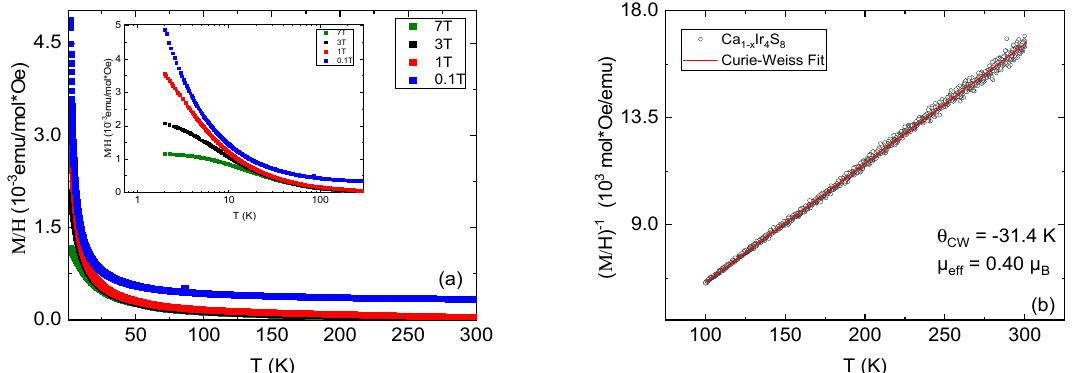
Figure 5. ( a ) Magnetization as a function of temperature for Ca 1 − x Ir 4 S 8 at different magnetic fields. Inset shows the logarithmic scale at low temperature; ( b ) Curie–Weiss analysis. Iridium ions in the parent compound Ca 2+ Ir 3+ 4 S 2 − 6 (S 2 ) 2 − have electronic